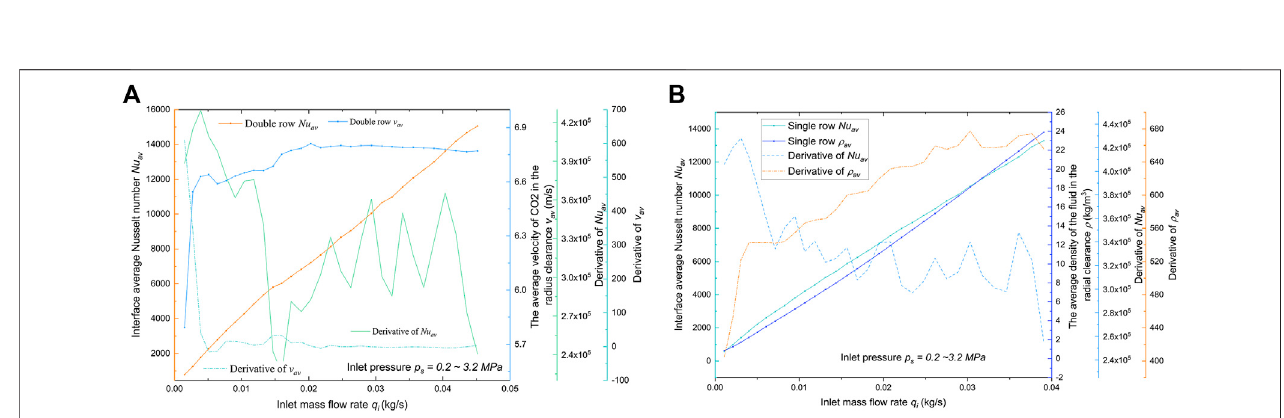
FIGURE 5 | Factors affecting heat transfer ef fi ciency: predicted Nu av at interface, the average velocity v av of the air fl ow in the radial clearance and their derivatives with respect to mass fl ow rate q i , versus q i . (A) Double row, (B) Single row.